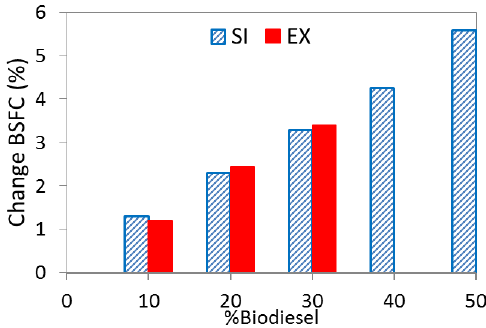
Figure 10. Relationship between BSFC and biodiesel blending ratio of simulation (SI) and experiment (EX).